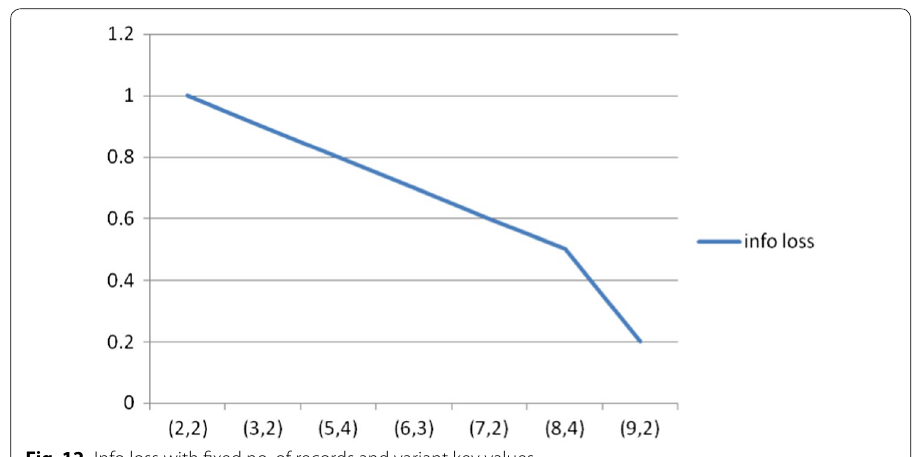
Fig. 12 Info loss with fixed no. of records and variant key values